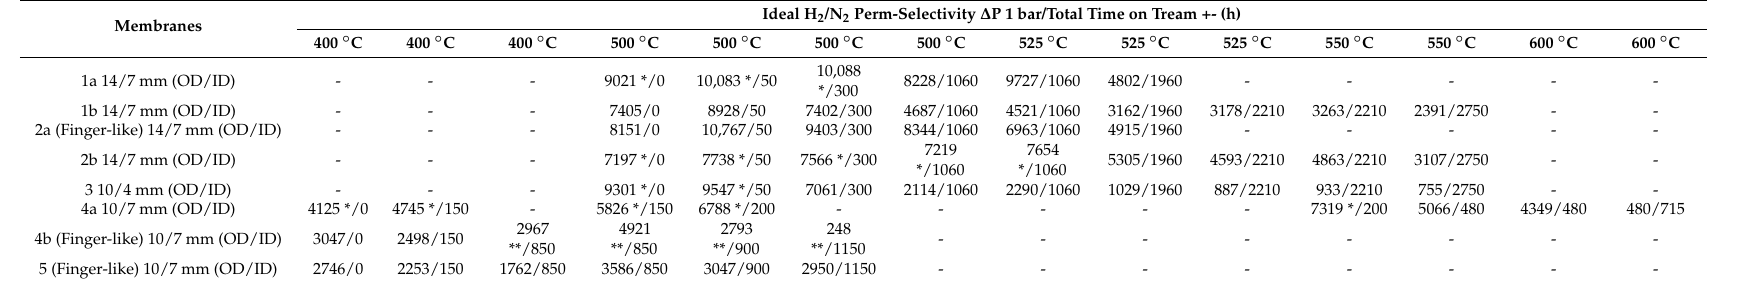
Table A1. Ideal H 2 /N 2 perm selectivity during the tests for all membranes